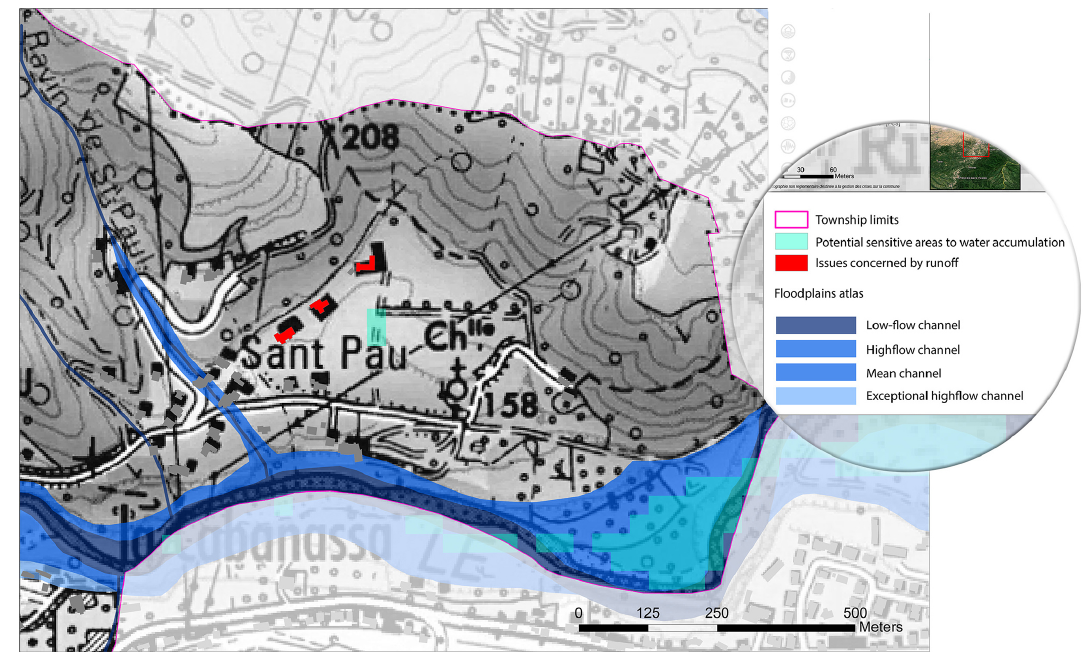
Figure 5. Extract of the rainwater runoff risk analysis map. Reynes (66).